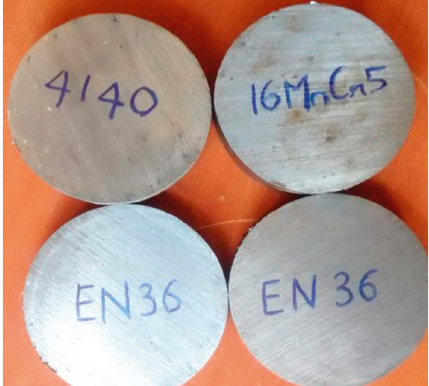
Figure 2: Surface-treated specimen (AISI 4140, EN36, and 16MnCr5).